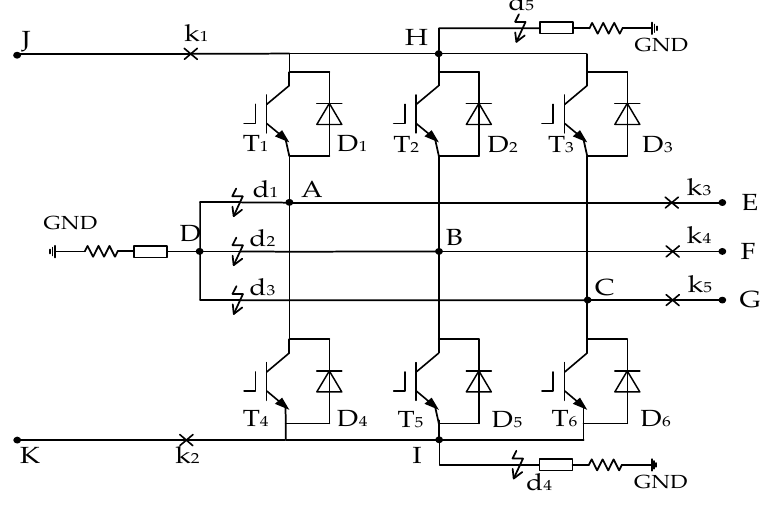
Figure 4. Three-phase full-bridge inverting circuit.